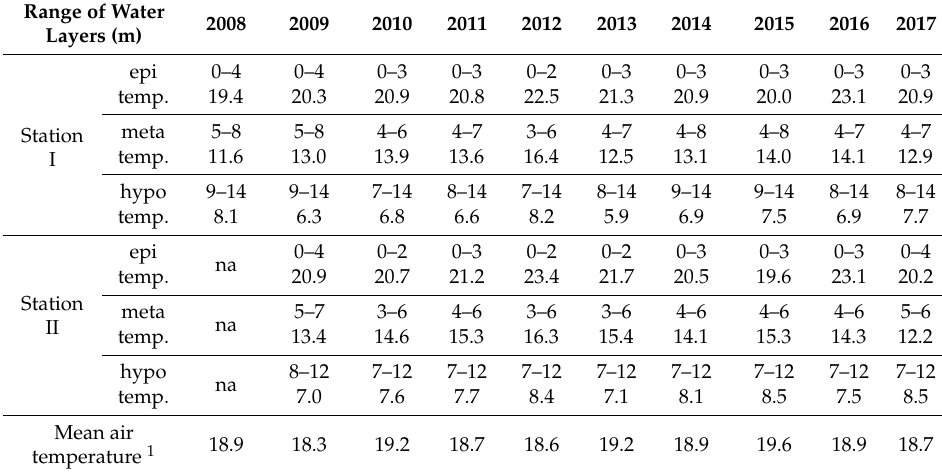
Table 1. Range of individual thermal layers of water in subsequent years of research (m) and mean water temperature in the period June–August ( ◦ C) at two stations compared to the average air temperature in the same period ( ◦